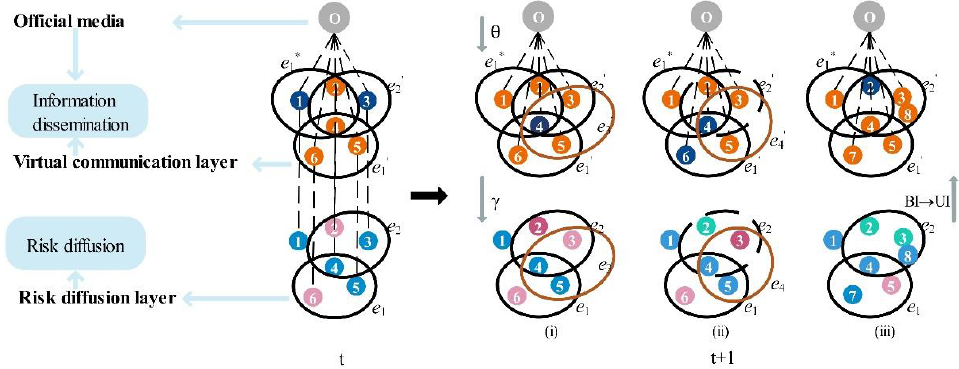
Figure 3. Schematic diagram of the model evolution mechanism. The virtual information layer has two node states: Unbelieve (orange), Believe (navy). The risk diffusion layer has four node states: Susceptible (blue), Exposed (pink), Infected (fuchsia), and Recovered (green). At each time step t , the upper and lower network structures evolve via Figure 1, processes (i)-(iii) correspond to the three processes in Figure 1, respectively, i.e., addition of hyperedges, rewiring of hyperedges, entry and exit of nodes; the node status is updated via Figure 2. Hyperedges e ∗ exchange between non-cooperative enterprises.